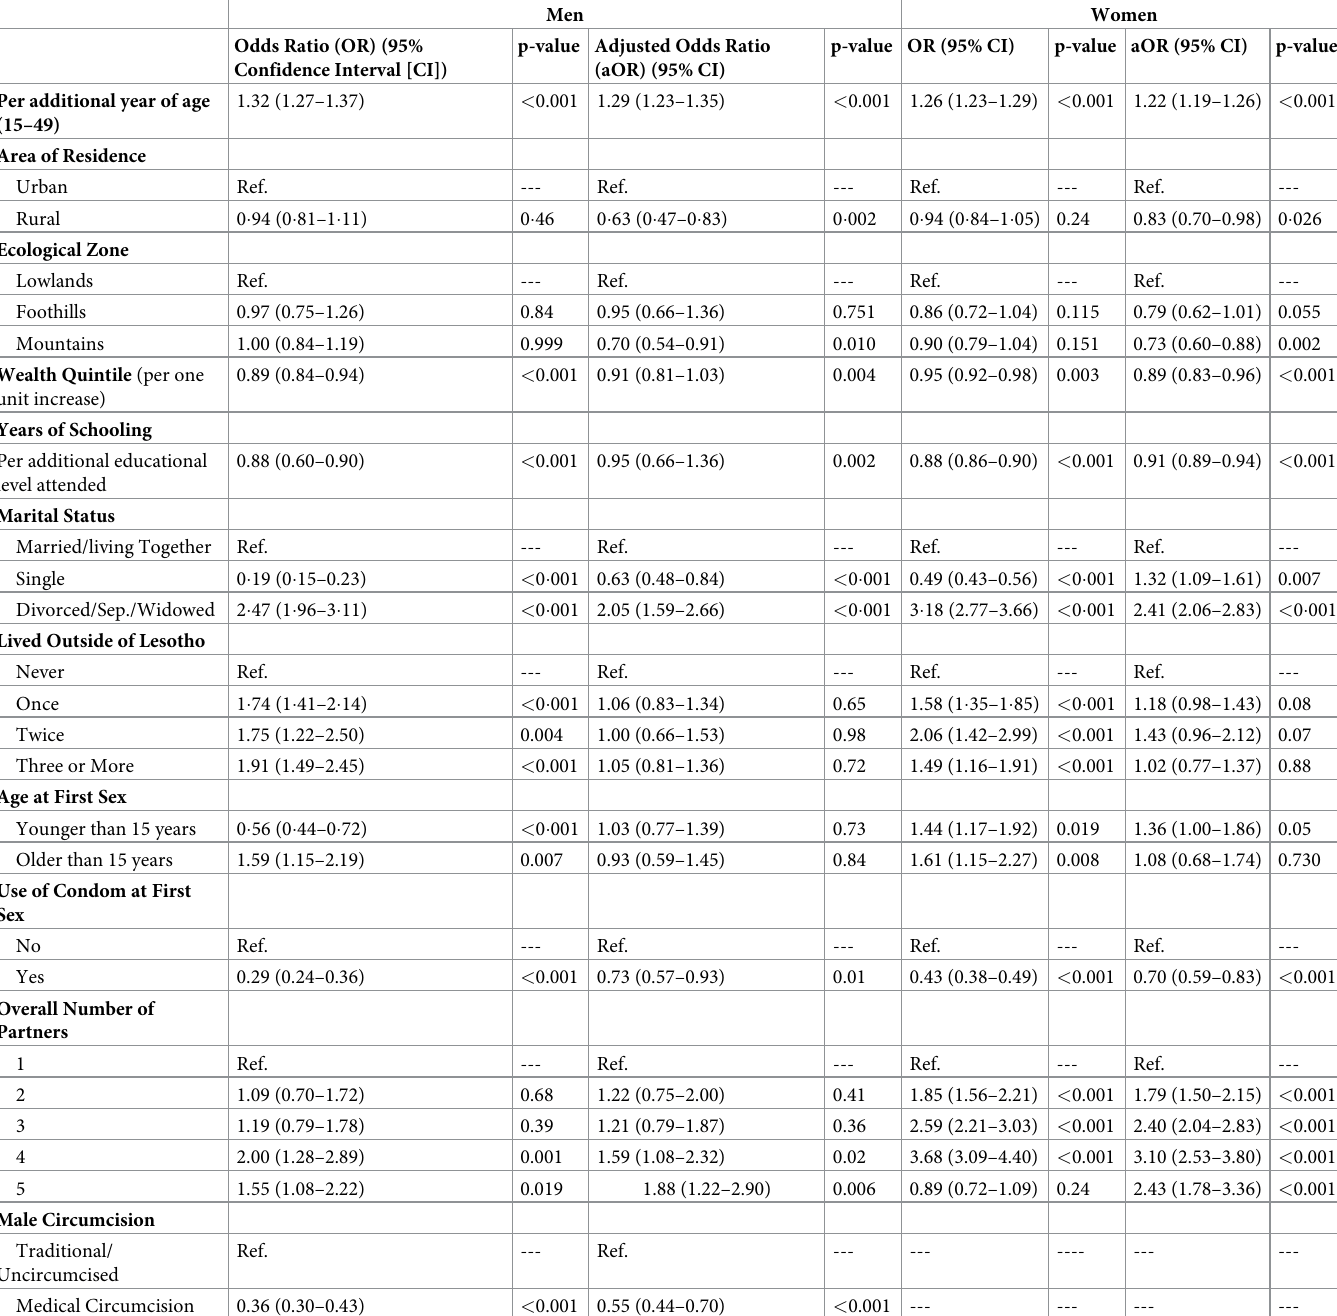
Table 3. Predictors of HIV infection (prevalence) in participants aged 15–59 years by sex, Lesotho Population-based HIV Impact Assessment 2016–2017 � . Men Odds Ratio (OR) (95% Confidence Interval